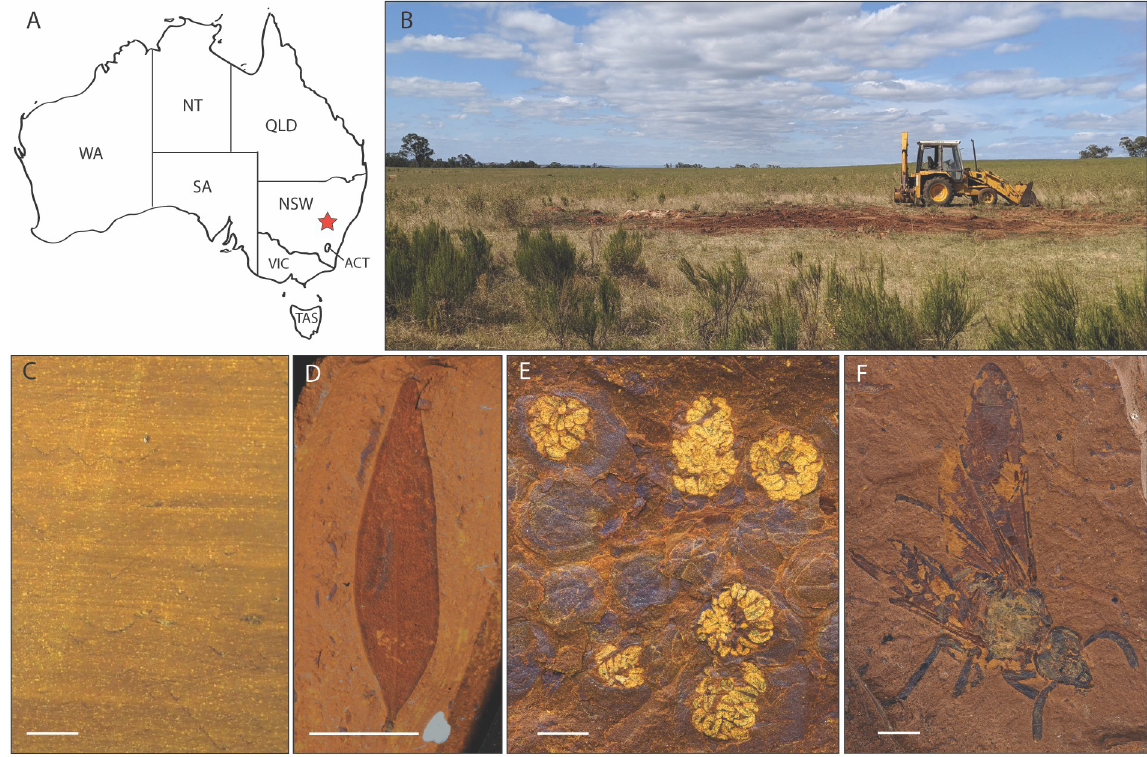
Fig 1. Location and fossils of McGraths Flat. ( a ) Map of Australia depicting the location of McGraths Flat (red star) near the town of Gulgong, Central Tablelands, New South Wales, Australia. ( b ) Field site. ( c ) Cross-section of the finely-bedded goethite-rich sedimentary rock from McGraths Flat. ( d ) Myrtaceous (eucalypt) leaf (AM F.146592). ( e ) Budding Malvales(?) flowers (AM F.146589). ( f ) Sawfly (Tenthredinoidea: Symphyta) (AM F.145093). ( d-f ) modified from McCurry et al ., 2022. Note the variation in colour (yellow-red-brown) is dominantly due to grain size, the overall composition is homogeneous. Scale bars, c —1 cm, d —1 cm, e —1 mm, f —2 mm.